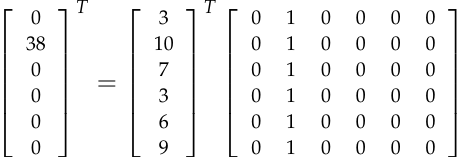
> 0 loops are not ii w ii